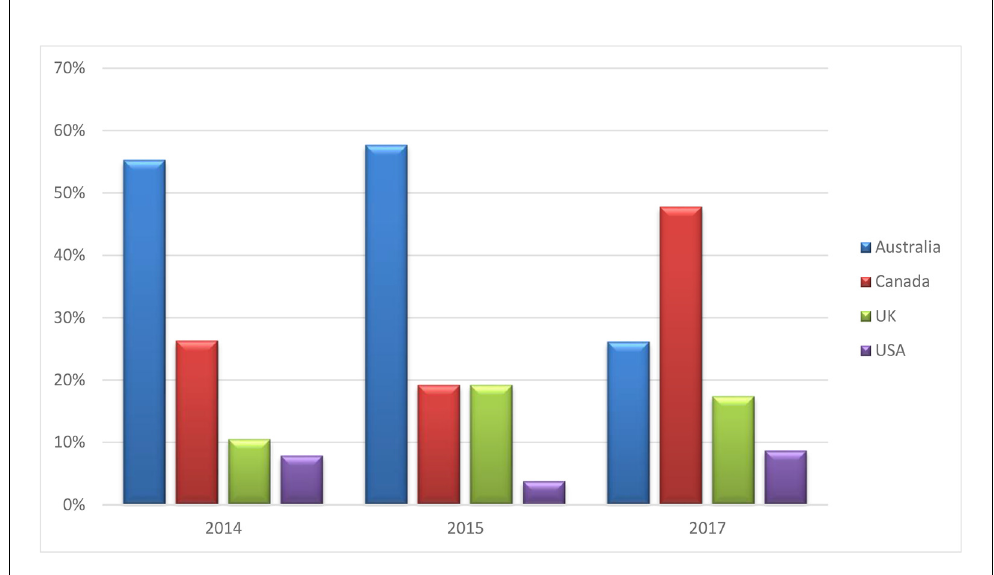
Figure 1. Current location of GP graduates who had already emigrated at the time of the survey.